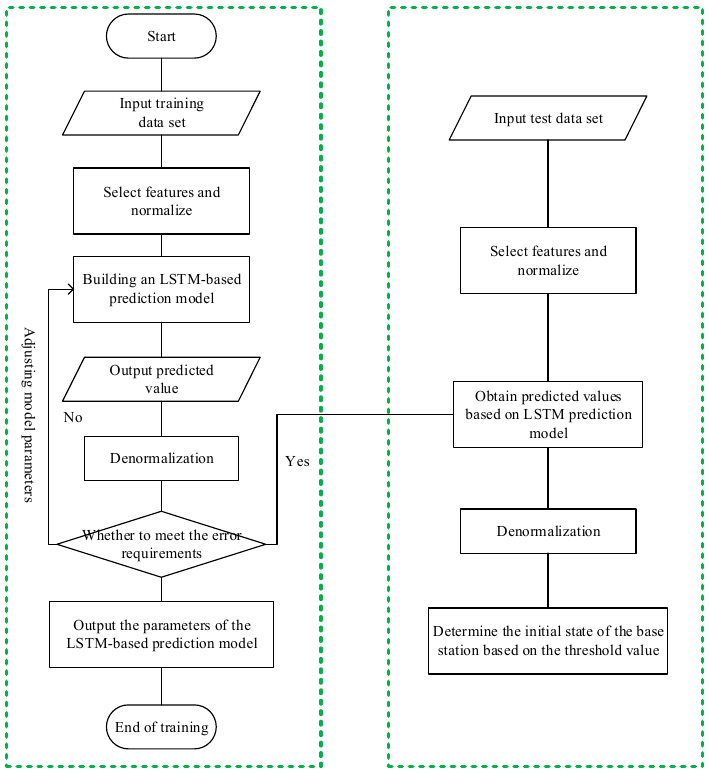
Figure 4. Training and testing flow chart of the LSTM network prediction model.